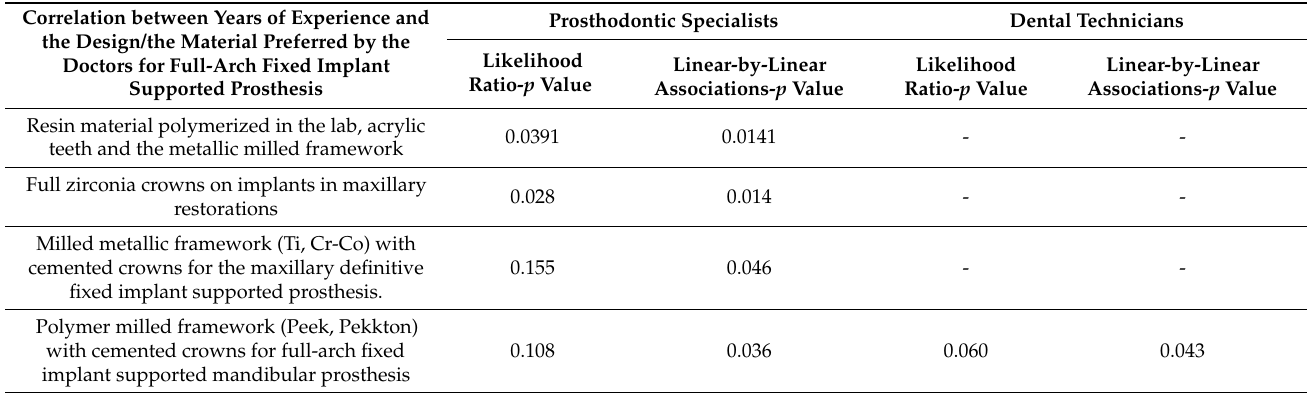
Table 4. Correlation between Years of Experience and the Design/the Material Preferred by the Doctors for Total Fixed Implant Supported